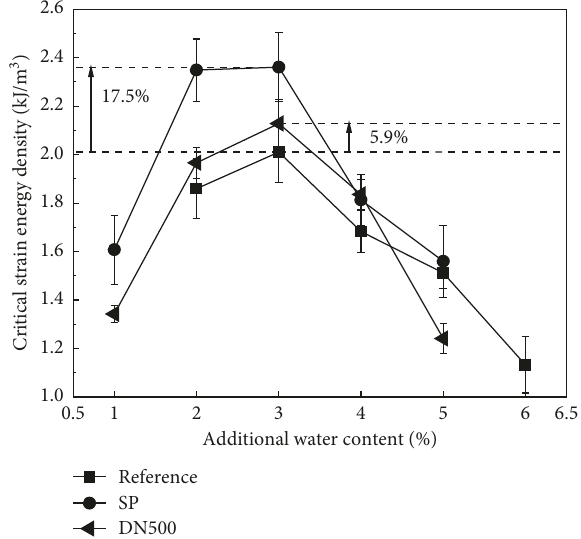
Figure 12: The CSED of CRME with different additional water contents and